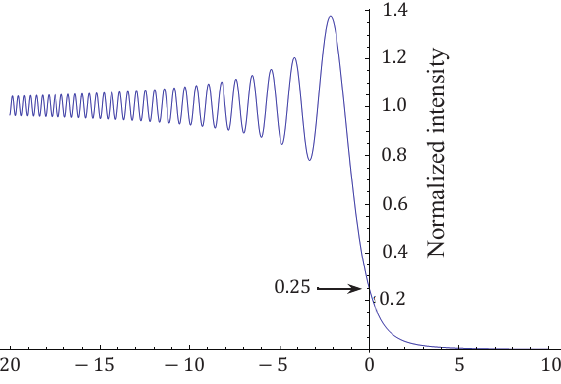
Fig.3 . Normalized intensity in the far field of a sharp edge as a function of distance along the ) from the edge of the geometric shadow, where (cid:1876) (cid:1876) -axis (at fixed (cid:1878) (cid:3116)